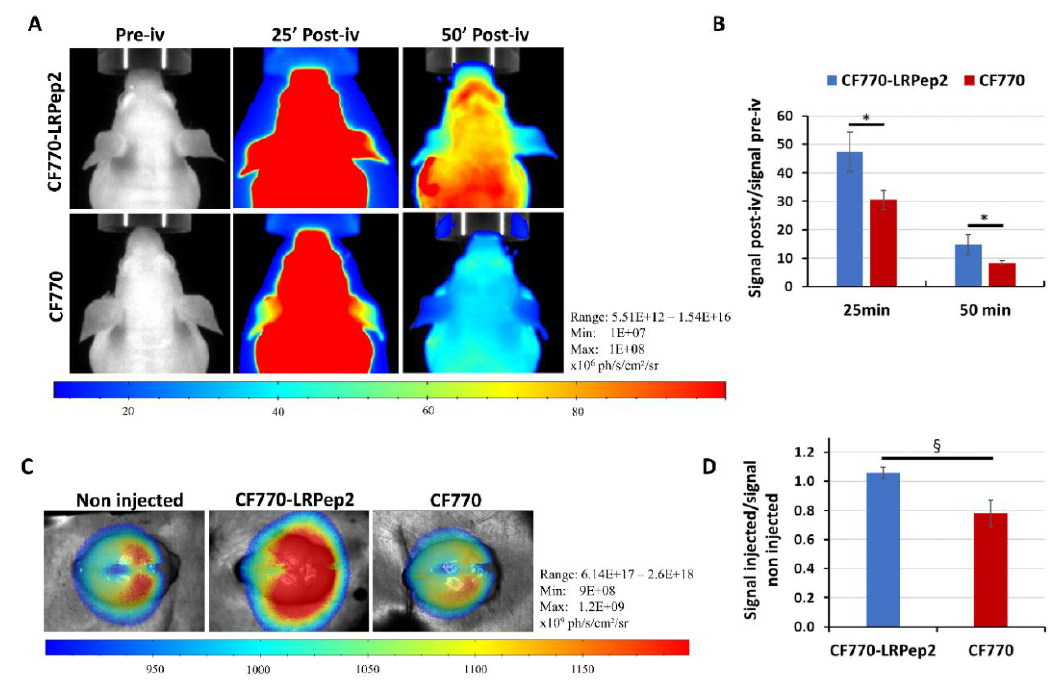
Figure 10. ( A ) FLI images of the brains of nude mice before (pre-iv) and after injection of CF770-LRPep2 or CF770 (post-iv). ( B ) Analysis of the fluorescence observed on FLI images, measured by the M3Vision software in the brain area, and normalized to the pre-iv signal. * p < 0.05. ( C ) FLI images of mouse brains ex vivo. ( D ) Analysis of the fluorescence of the brains ex vivo normalized to the brain signal of a non-injected mouse. § p = 0.05.